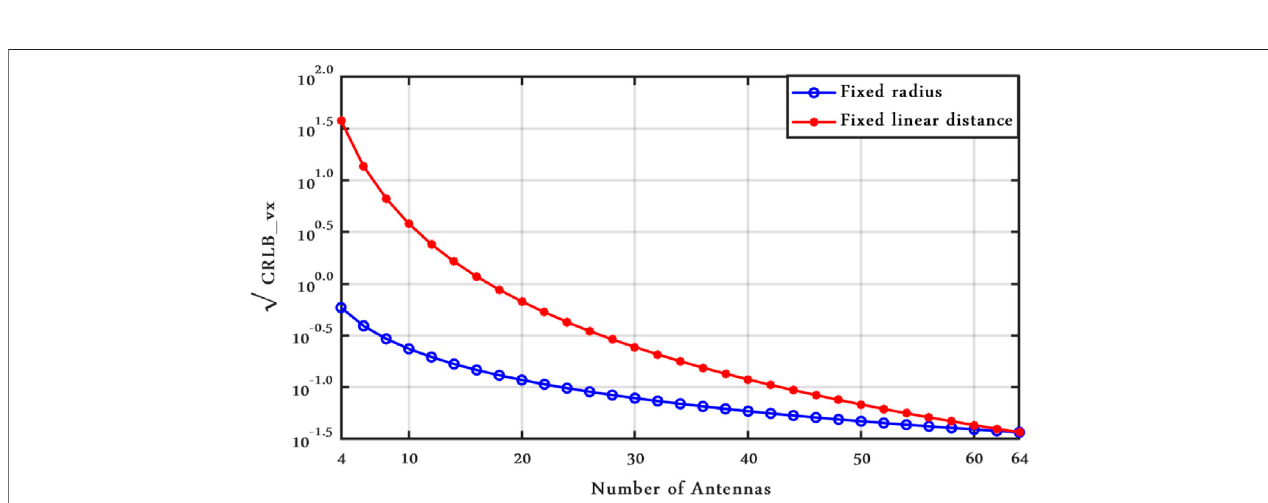
FIGURE 15 | CRLB x vs. number of antenna, Clutter Model I with ] = 2.1, SCR = 0 dB , and v x = v y = 50 m/s.